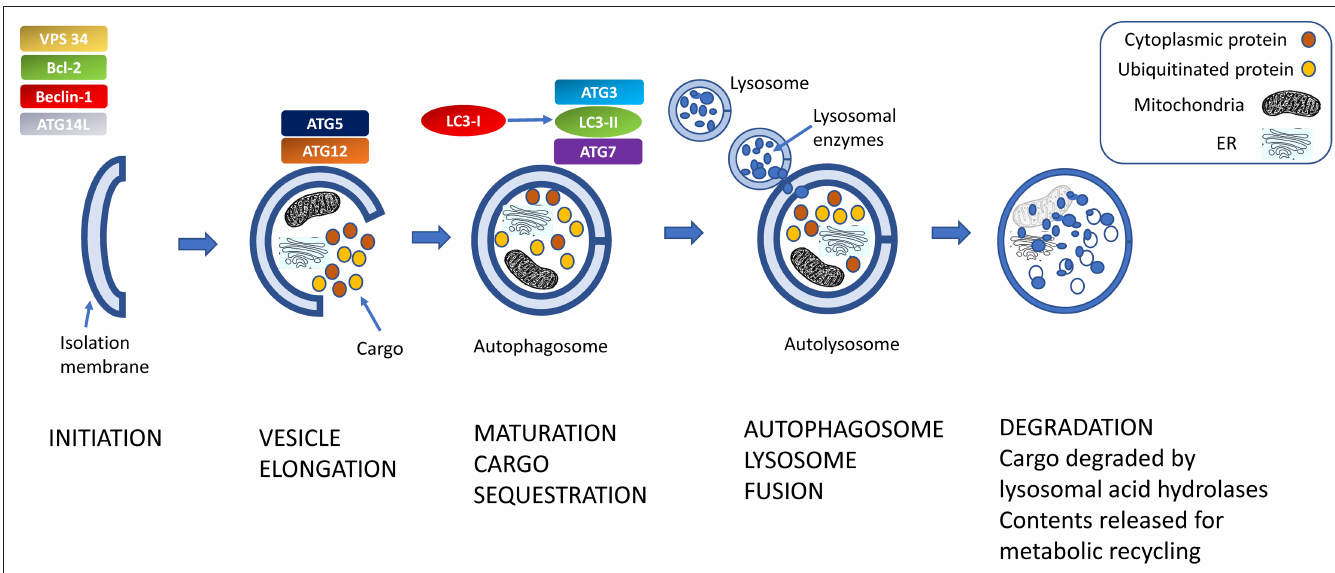
Figure 1. Stages of the autophagic pathway (essential autophagy proteins for each stage are shown in brackets). ATG, autophagy-related gene; BcL-2, B-cell lymphoma 2; ER, endoplasmic reticulum; LC3, microtubule-associated protein 1A/1B light chain 3; VPS34, Class III phosphoinositide